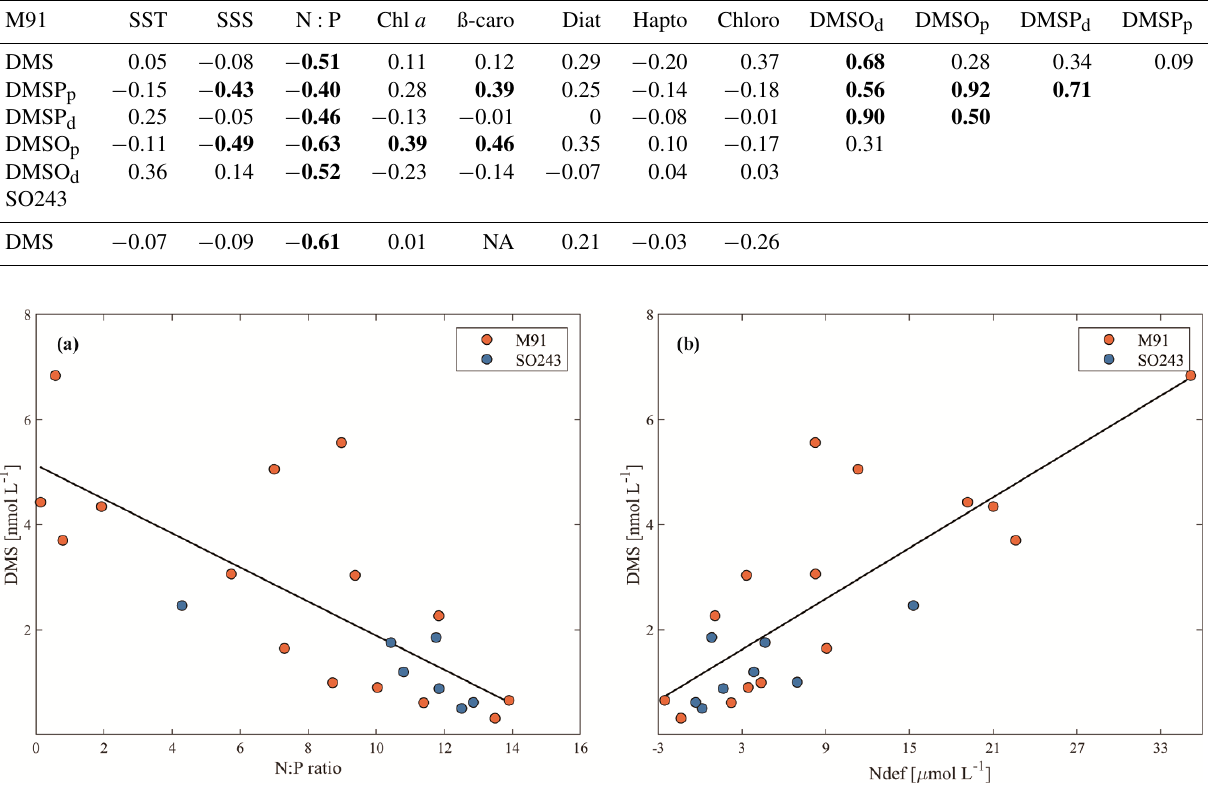
Figure 4. (a) N : P ratio vs. surface DMS concentrations in the coastal Peruvian upwelling ( y = − 0 . 32 x + 5 . 14, r 2 = 0 . 58, p = 3 . 61 × 10 − 5 , n = 22). (b) Ndef vs. surface DMS concentrations in the coastal Peruvian upwelling ( y = 0 . 16 x + 1 . 14, r 2 = 0 . 67, p = 3 . 62 × 10 − 6 , n =